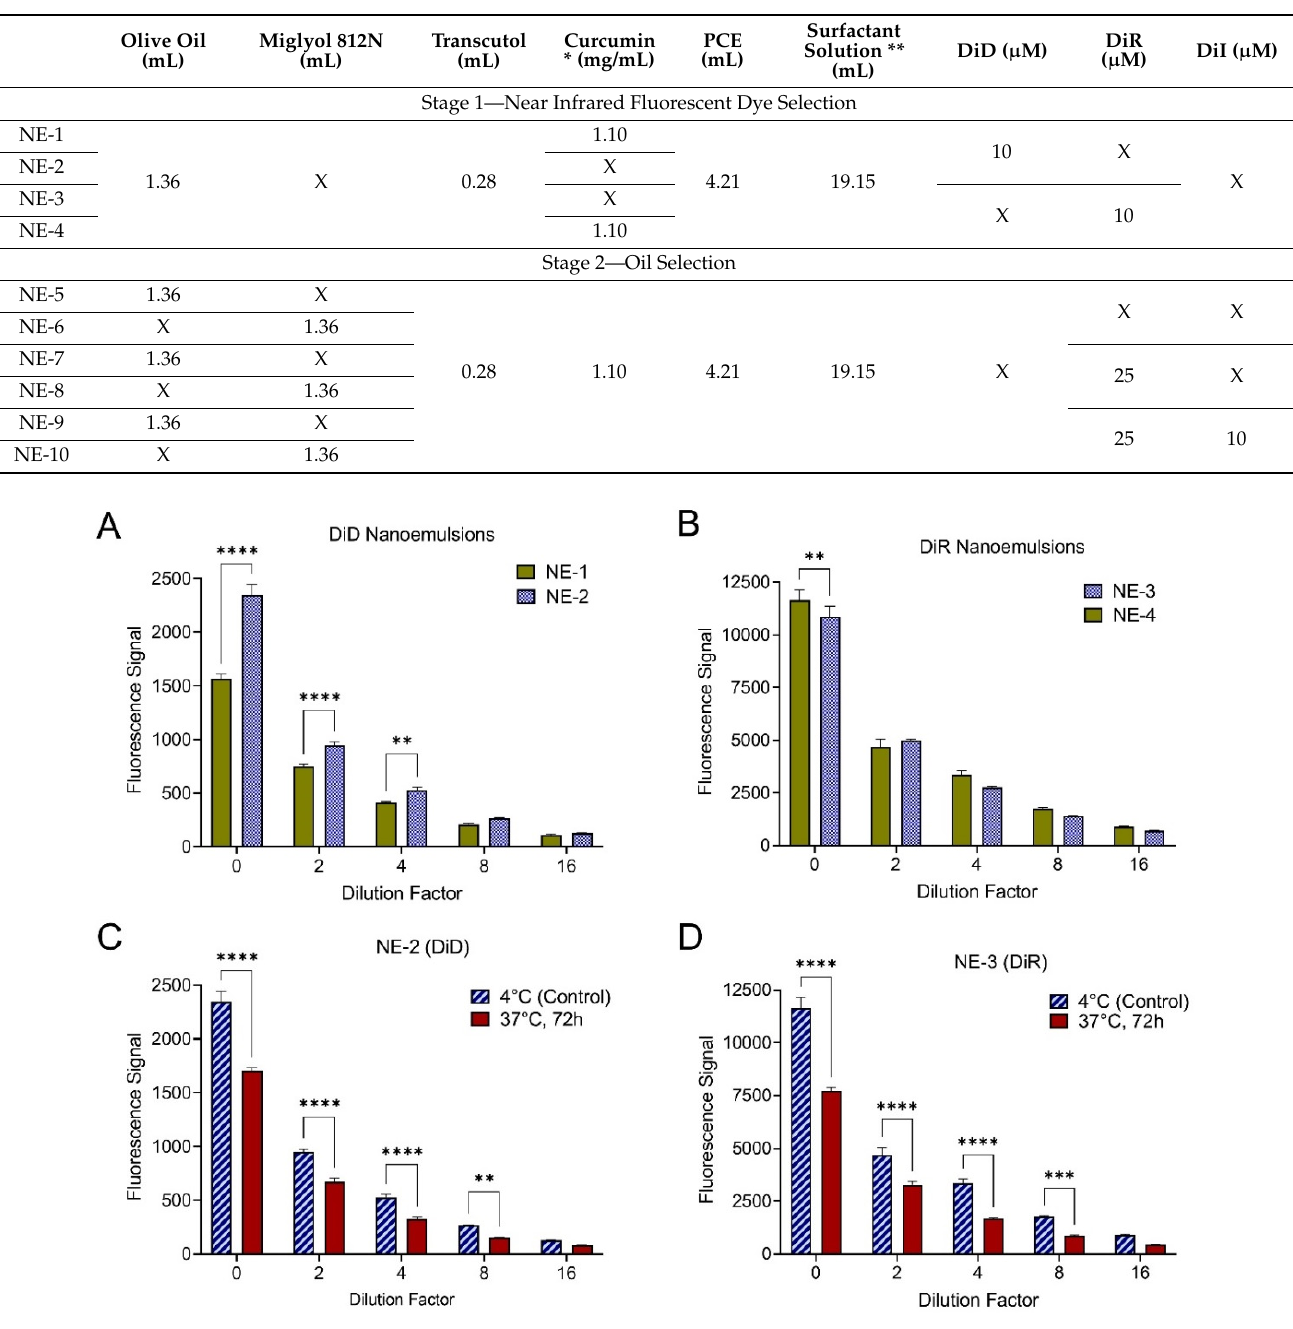
Figure 6. The impact of curcumin on fluorescence signal of nanoemulsions containing DiD (Panel A ) and DiR (Panel B ). The fluorescence signal of nanoemulsions stored at 4 °C was measured at several dilutions in de-ionized water. ( C , D ) The impact of 72 h incubation at 37 °C on fluorescence stability. Incubation significantly decreases the fluorescence signal of DiD (Panel C ) and DiR (Panel D ). ** p -value < 0.01; *** p -value < 0.001; **** p -value < 0.0001.